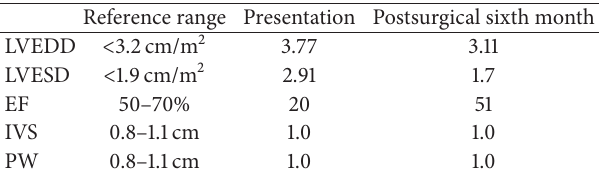
Table 2: Echocardiography measurements at presentation and six months after